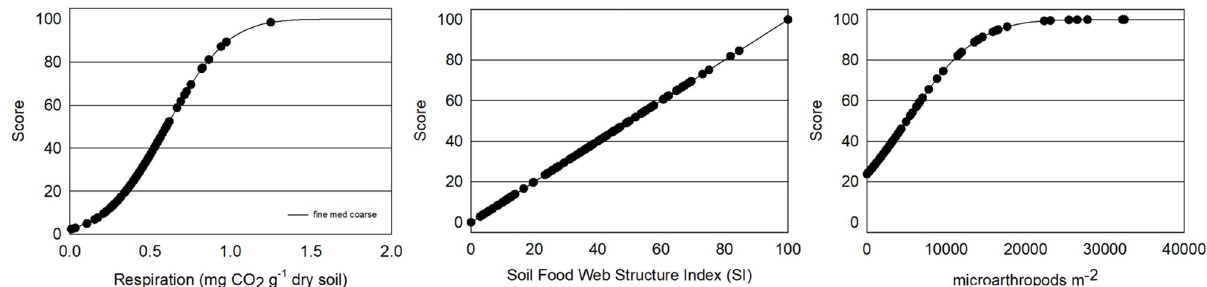
Fig 6. Indicators of soil biological activity and food web community structure: Respiration (mg CO 2 g -1 ), soil food web structure index (0–100 scale) and micro arthropods (m -2 ) in 101 Central Washington orchards fields.